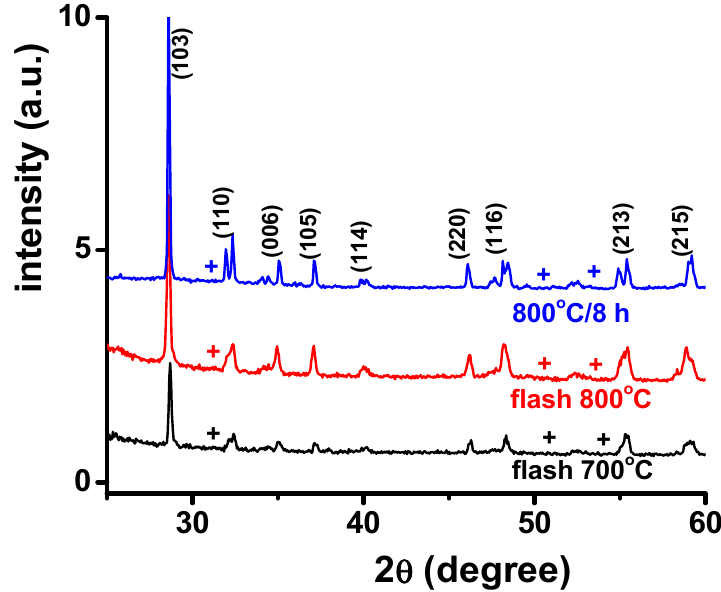
Figure 8. X-ray diffraction patterns of BITIVOX. From top to bottom: sintered at 800 °C/8 h, flash Figure 8. X-ray di ff raction patterns of BITIVOX. From top to bottom: sintered at 800 ◦ C / 8 h, flash sintered with application of 200 V cm − 1 at 800 ◦ C / 5 min and at 700 ◦ C / 5 min. Also shown the main sintered with application of 200 V cm − 1 at 800 °C/5 min and at 700 °C/5 min. Also shown the main Miller indices; + location of di ff raction peaks of BiVO 4 Miller indices; + location of diffraction peaks of BiVO 4 .